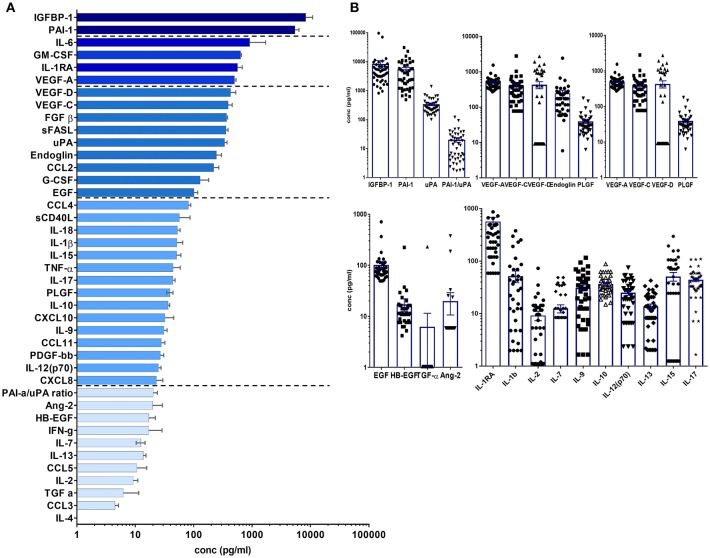
Cytokine/chemokine and tissue factor composition of human perilymph fluid. (A) Human perilymph fluid comprises high concentrations of epithelial and endothelial proteins like IGFPB1, VEGF-A,-C,-D, some innate cytokines like IL-6, followed by chemokines and typical cytokines of the adaptive immune system like IFN-g, I-17, etc. Concentrations were determined from n = 44 perilymph samples, median concentrations ± SEM are displayed in a waterfall plot. (B) In order to show that most proteins were detected in all patient, the concentrations of individual proteins are shown for each sample using log scale graphs.